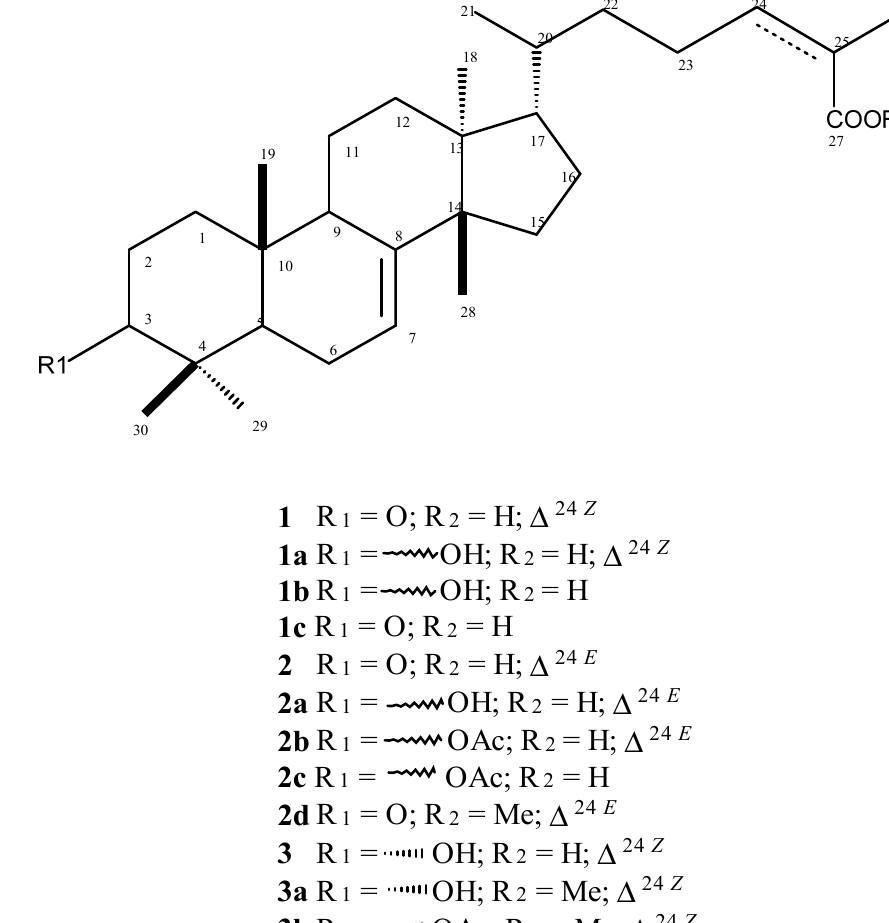
Figure 1. Structures of natural compounds 1 – 3 and semi-synthetic 1a – c , 2a – d , 3a , and 3b tirucallane